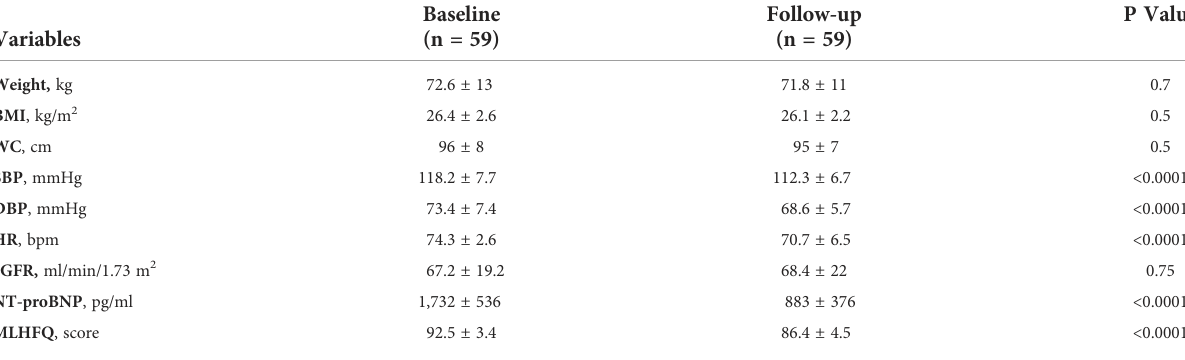
TABLE 2 Anthropometric, hemodynamic, and biohumoral characteristics at baseline and after 24 weeks of therapy with sac/val.